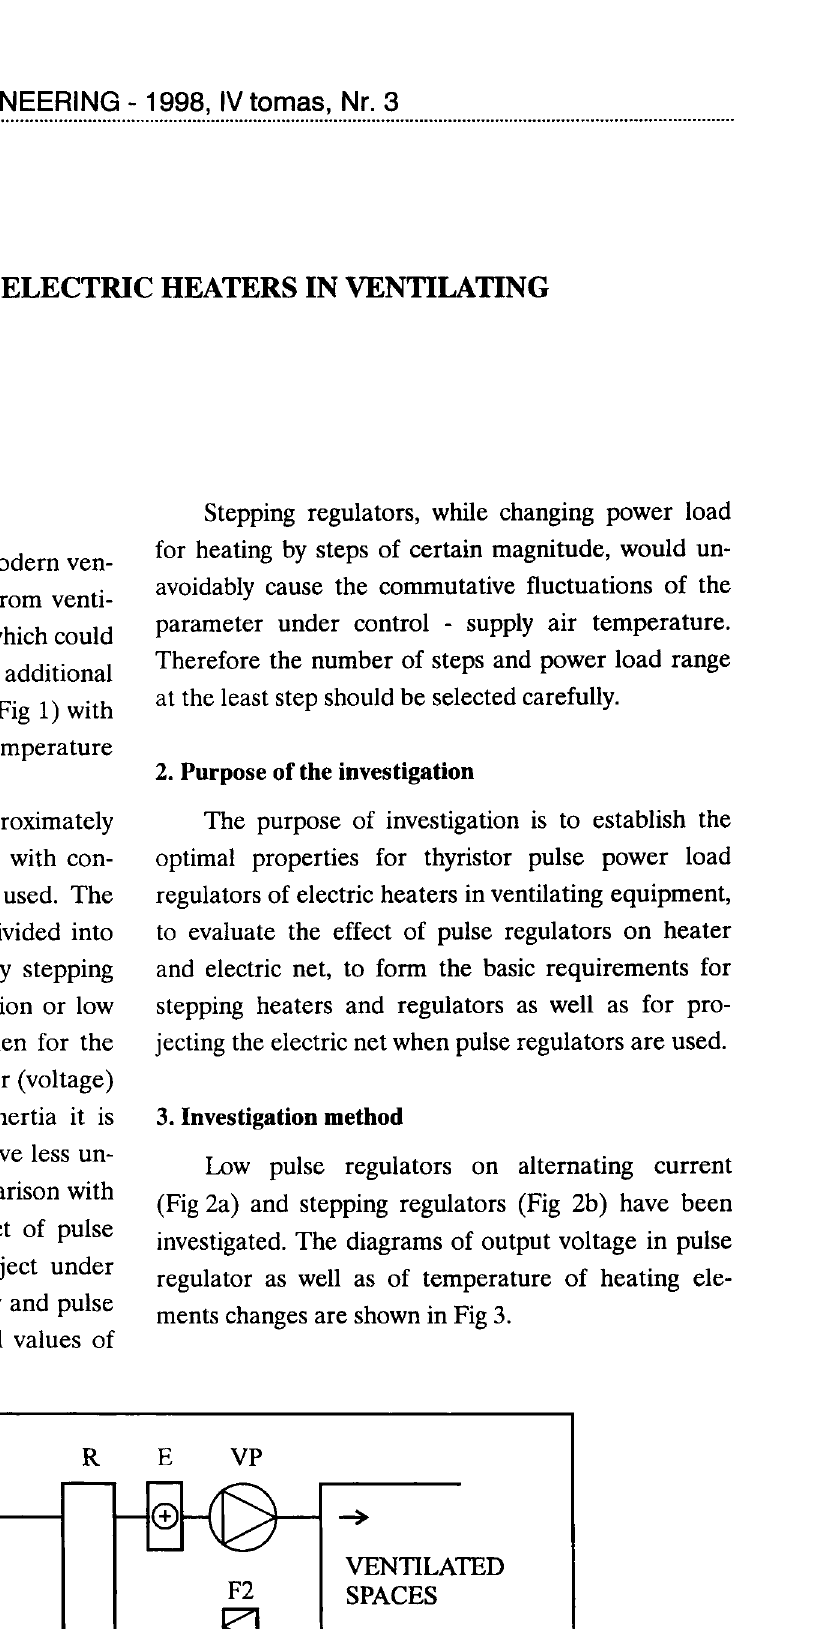
Fig 1. Simplified functional scheme of ventilating equipment: F - air filters; VP , VI - supply and extracting fans; R - rotating or plate heat recovery unit; E - heater for supply air